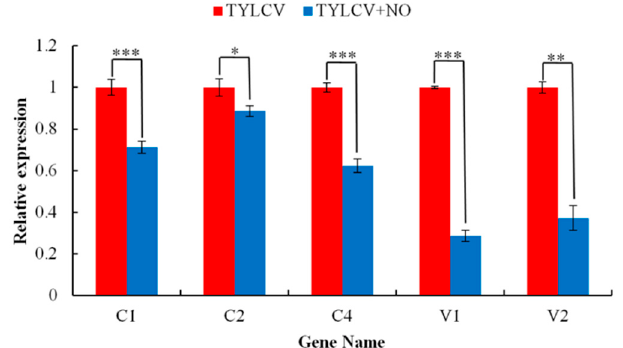
Figure 13. Effect of exogenous NO on the copy number of viral genes. * Means significant difference ( p < 0.05), ** Means extremely significant difference ( p < 0.01), *** Means highly significant difference ( p < 0.001).